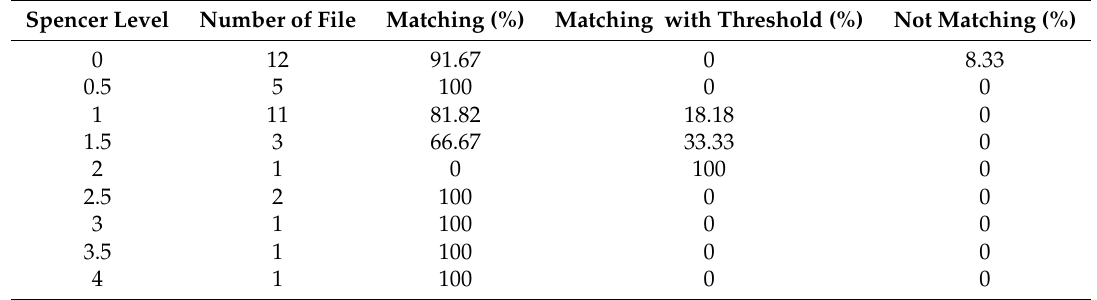
Table 1. Comparison between the Spencer level obtained from the Drivers Alert Network (DAN) annotation and the empirical mode decomposition (EMD) algorithm